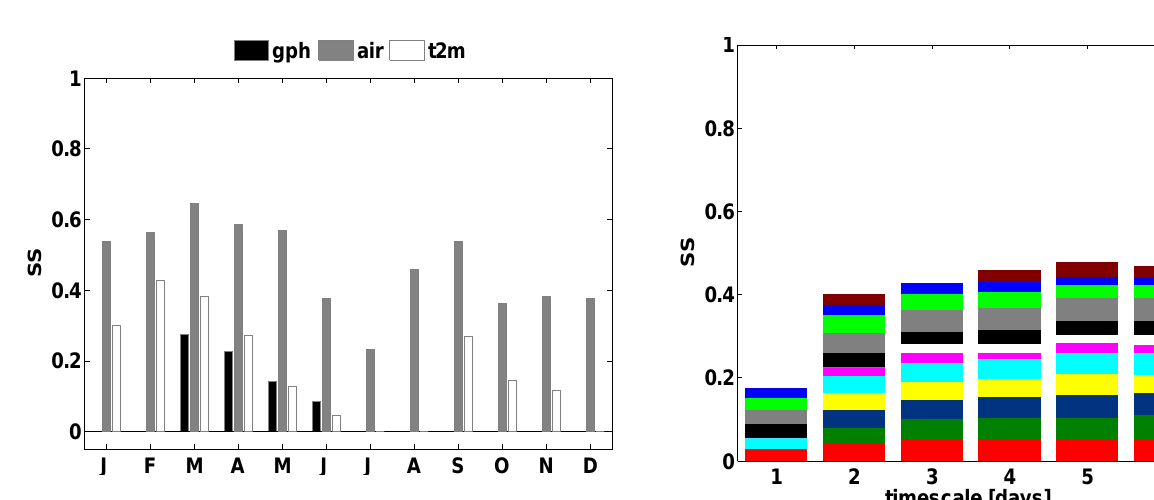
Figure 7. Values of SS for each month (here for AWS1), and the three predictors of those assessed in Sect. 4.4, which showed signif- icant results.